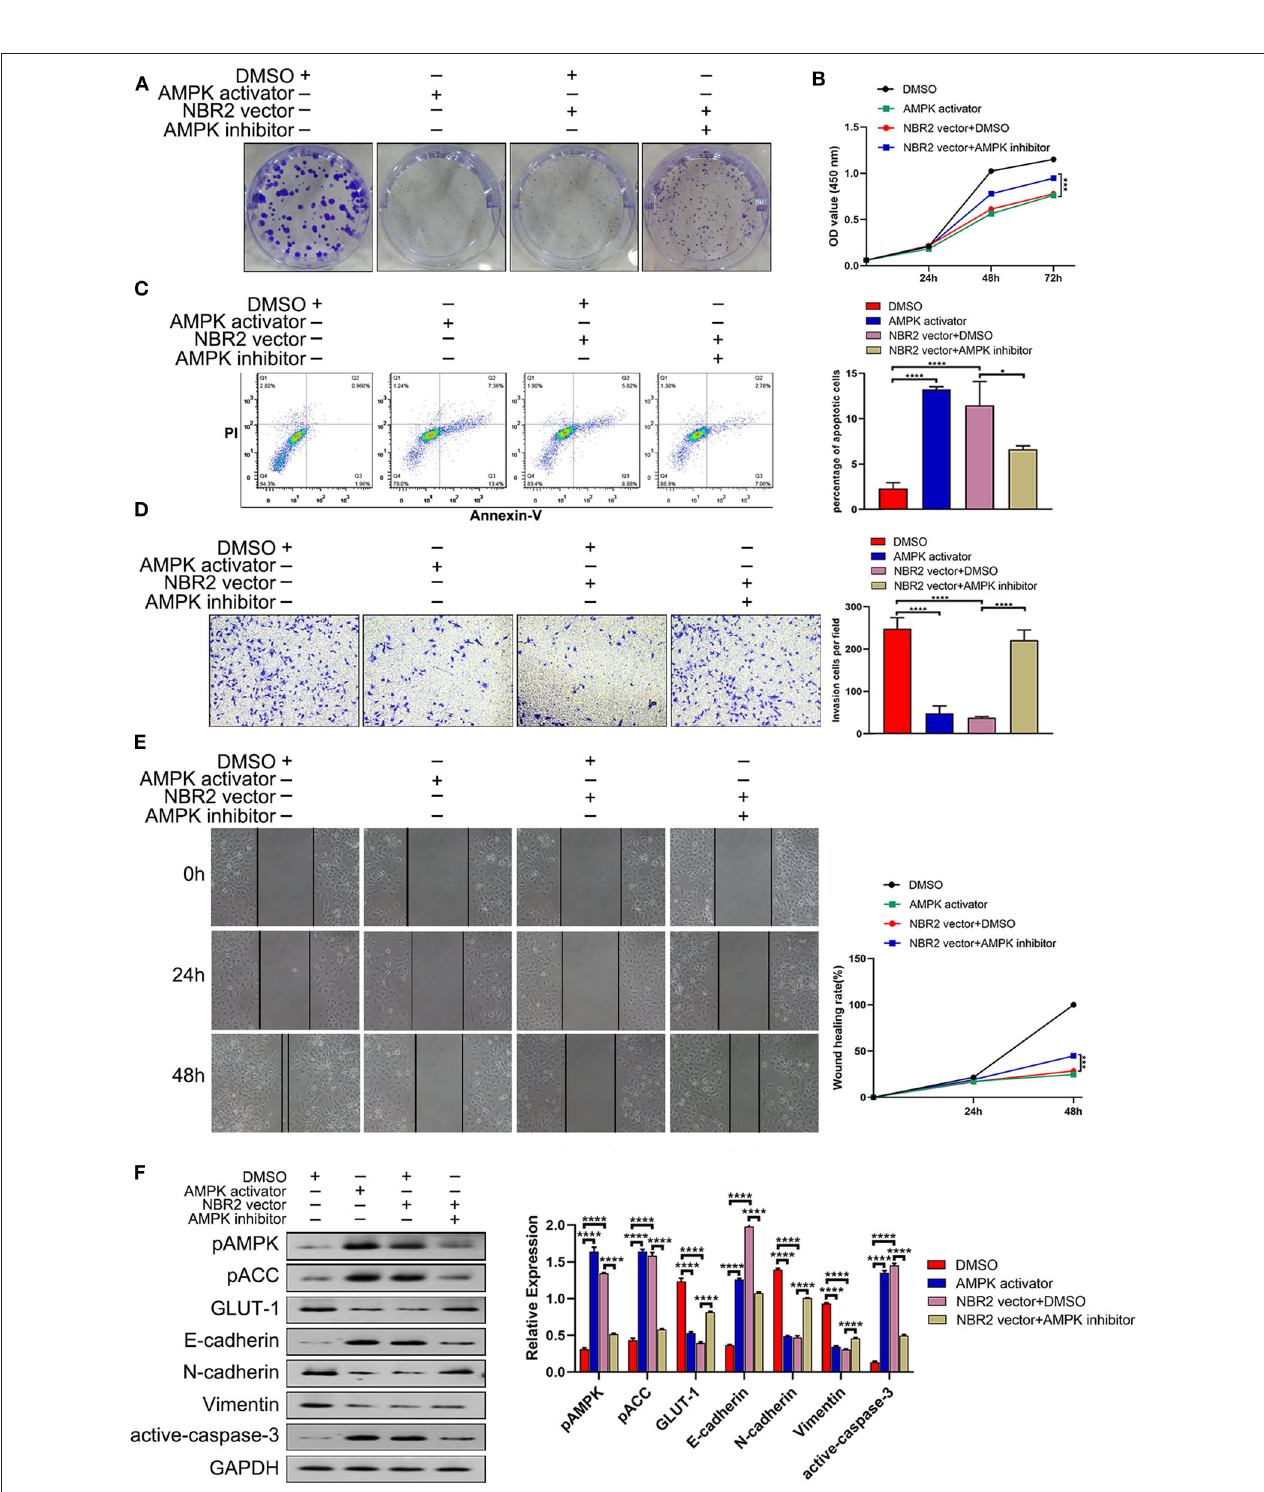
FIGURE 5 | Pharmacological modulation of AMPK activity affects the malignancy of TC cells. BHT101 or NBR2-expressing BHT101 cells were tested for their colony formation, proliferation, apoptosis, invasion, wound healing in the presence or absence of A-769662 (a specific AMPK activator, 100 µ M) or Compound C (a specific AMPK inhibitor, 20 µ M), respectively. Their AMPK/ACC activation, GLUT-1, EMT-related molecule, and cleaved caspase-3 expression were quantified by Western blot assays. (A) The colony formation. (B) CCK8 analysis of cell proliferation. (C) Flow cytometry analysis of apoptotic cells. (D) Transwell analysis of cell invasion. (E) Wound healing analysis . (F) Western blot analysis of the levels of GLUT-1, E-cadherin, N-cadherin, Vimentin, and cleaved-caspase-3 expression and AMPK and ACC phosphorylation in TC cells. Data are representative images or expressed as the mean ± SD of each group of cells from three separate experiments. * P < 0.05; **** P <